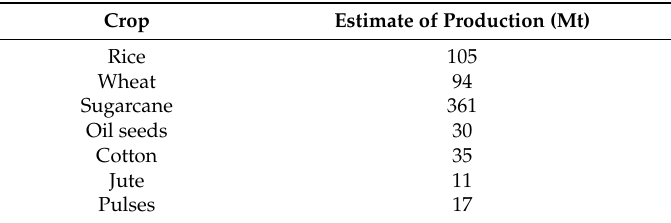
Table 3. Crop Production Estimate of Major Crops in India [7]